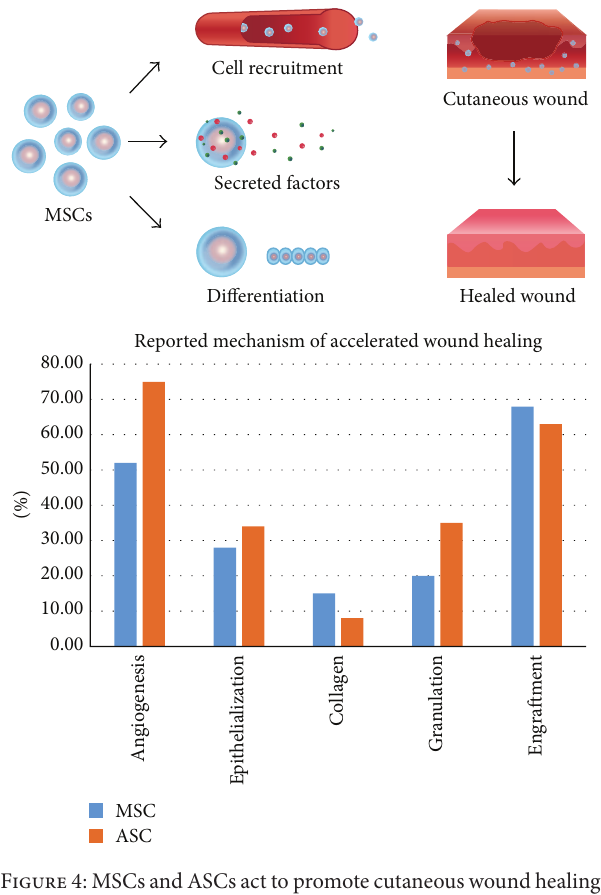
Figure 4: MSCs and ASCs act to promote cutaneous wound healing through a variety of mechanisms. MSCs and ASCs influence wound healing through a variety of mechanisms, including angiogenesis, promoting epithelialization, and enhancing collagen deposition and granulation tissue formation. In addition, various studies have demonstrated that transplanted cells engraft into the wound to participate in wound healing. Blue bars represent studies examining BM-MSCs and orange bars represent studies evaluating